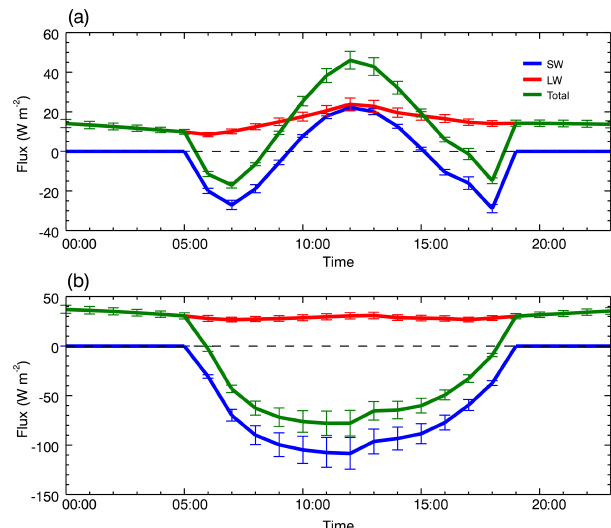
Figure 10. Mean diurnal direct radiative effect of dust averaged for 8–30 June 2011: (a) TOA and (b) surface. The bars show the stan- dard error over the diurnal